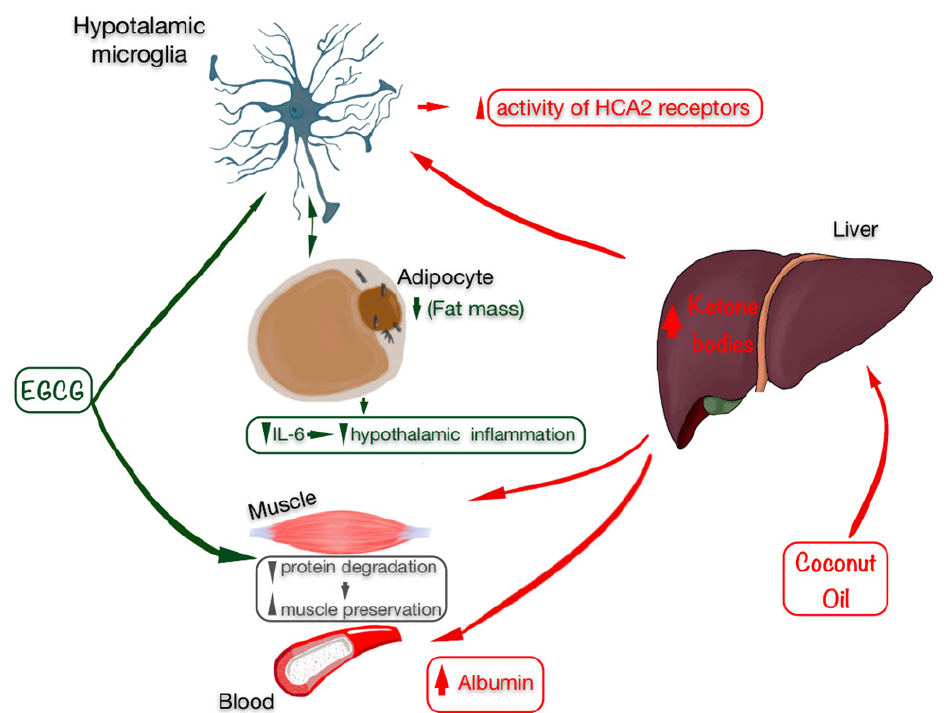
Figure 2. Beneficial effects of EGCG (marked in green) and coconut oil as a source of ketonic bodies (marked in red) on anthropometry by preserving skeletal muscle, improving the state of inflammation with an increase in albumin levels, and especially by decreasing fat mass, which is related to lower inflammation in the hypothalamus (microglia) and in the blood, decreasing IL-6 levels. Abbreviations: EGCG: epigallocatechin gallate; IL-6: interleukin 6.